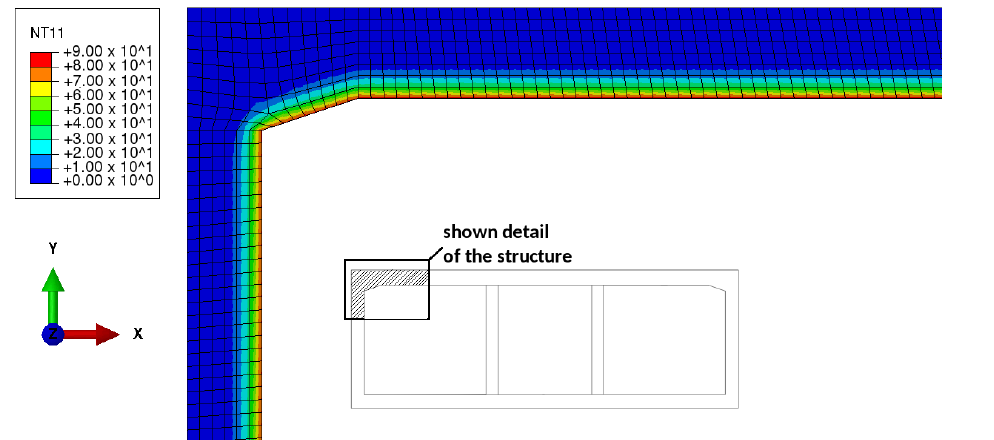
Figure 12. Temperature distribution obtained by prescribing a uniform surface temperature history, 30 min after the start of the thermal loading: detail showing the connection of the left wall to the top